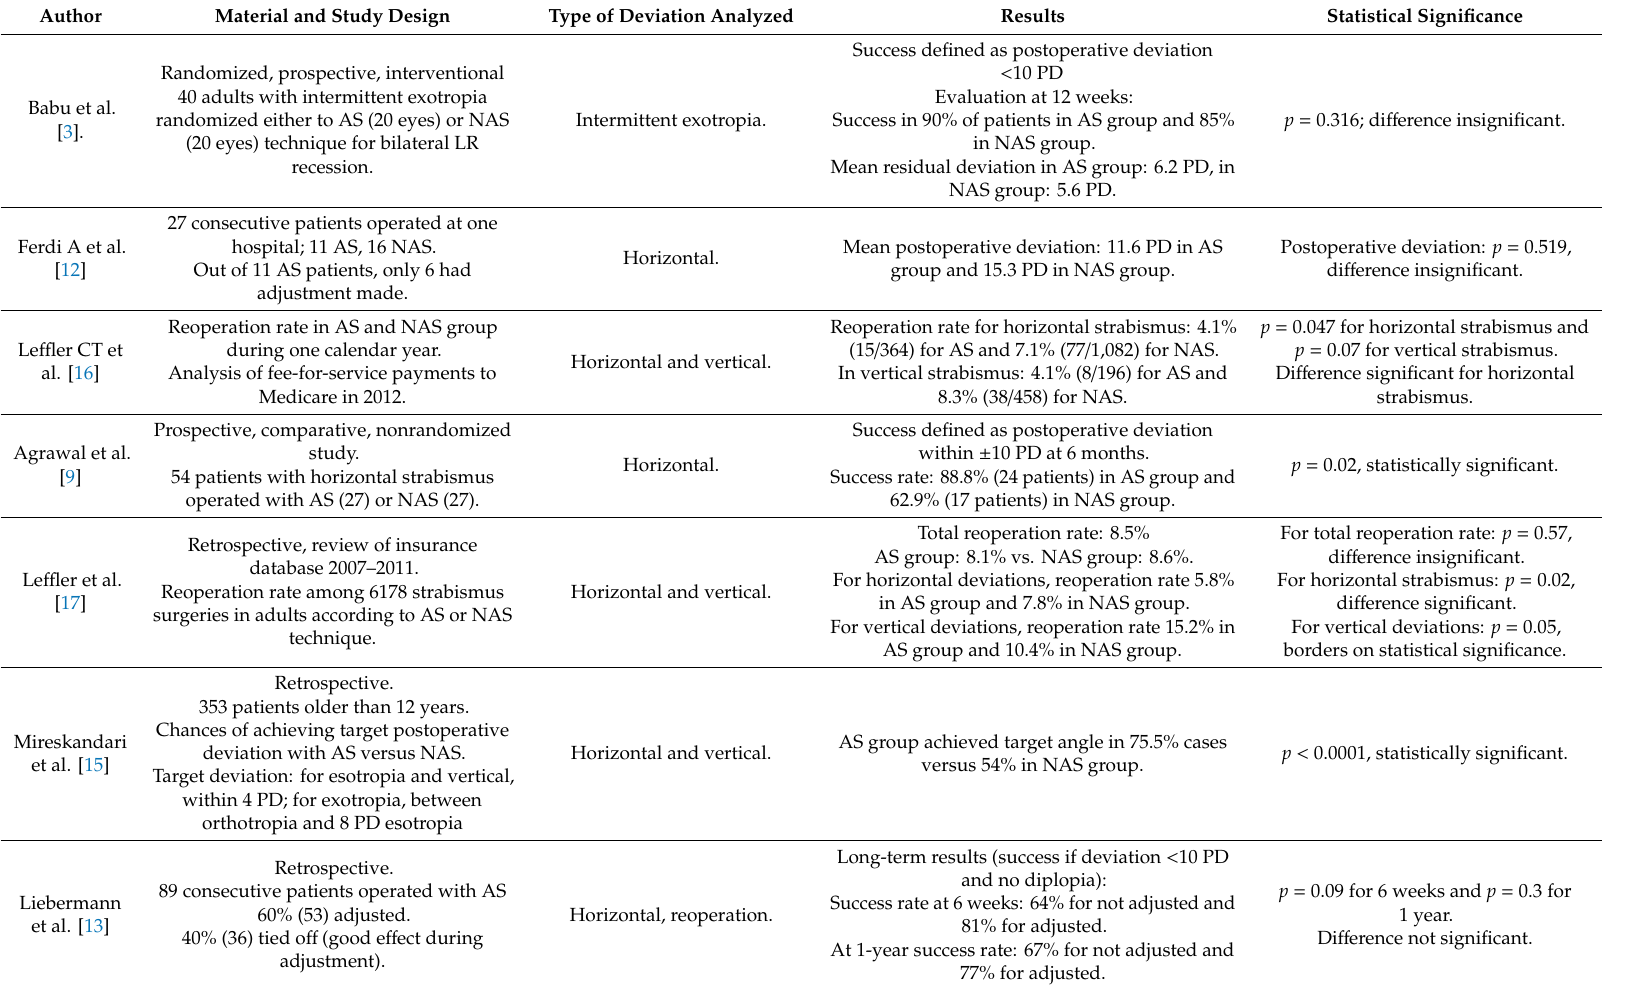
Table 1. Studies comparing the e ff ects of treatment according to AS versus